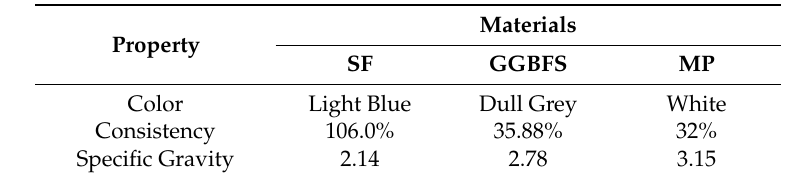
Table 1. Properties of major